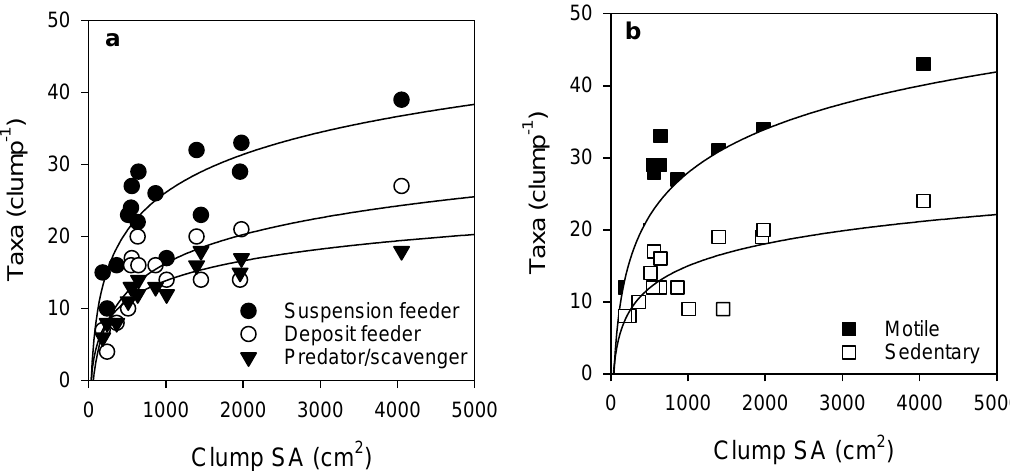
Figure 4. Relationship between Sabella clump surface area and epifauna taxa according to ( a ) feeding mode and ( b ) motility. Fitted curves all follow logarithmic equations (curve R 2 values: suspension feeder (0.69), deposit feeder (0.65), predator / scavenger (0.85), motile (0.69), sedentary (0.55), see Table S2 for further detail).